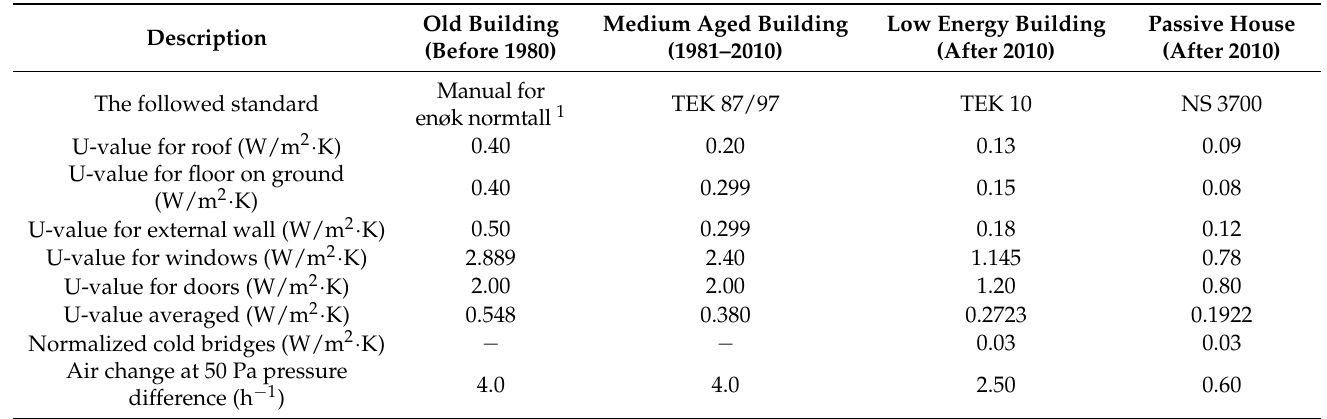
Table 2. Summary of the input data for the building